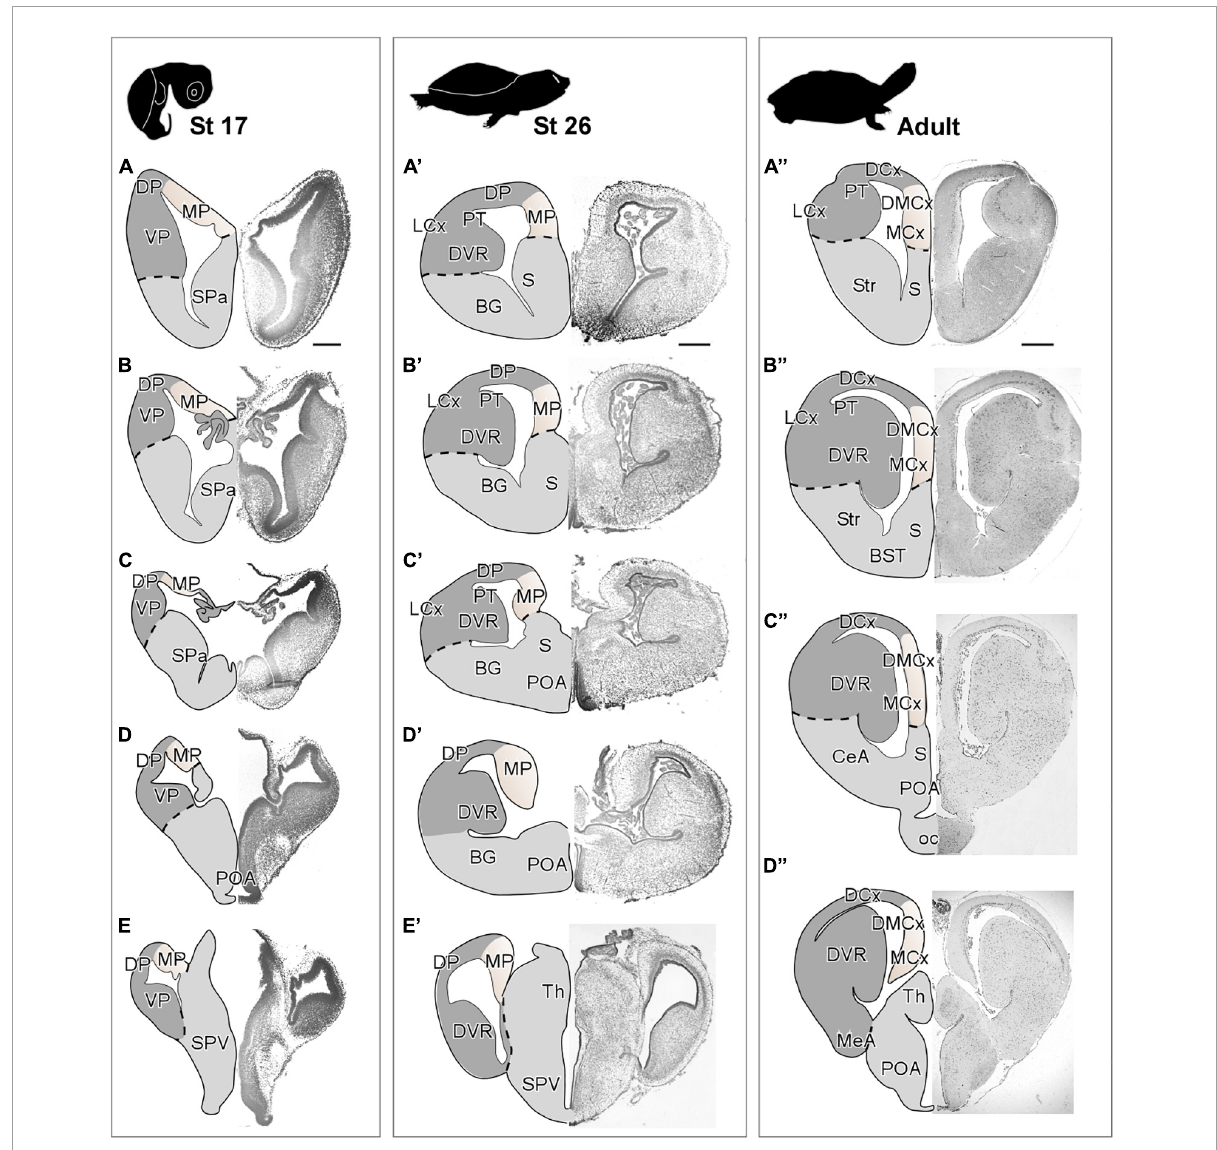
FIGURE2 Photomicrographs of transverse sections through the telencephalon of Trachemys scripta elegans at st 17 (A–E) , st 26 (A (cid:48) –E (cid:48) ) and adult (A"–D") . Nissl staining allowed the anatomical identification of the medial pallium during early (A–E) or late (A (cid:48) –E (cid:48) ) embryonic stages and adult (A"–D") . The region of the medial pallium is pink-colored in the drawings of telencephalon semi-hemispheres. Scale bar = 500 µ m. See the abbreviation